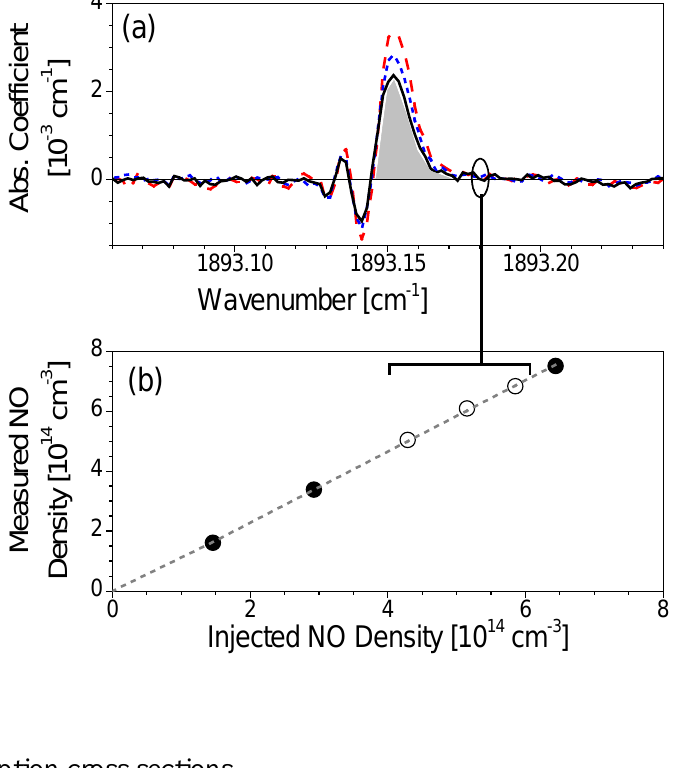
Figure 4. Sample spectrum and calibration curve of a stable molecular species, NO, obtained with a pulsed QCL under low pressure conditions. (a) Perturbed absorption coefficients of NO measured at 2.66 mbar (50 cm absorption length) for different mixing ratios (dashed—1.00%, dotted —0.80%, solid—0.67%. The patterned area was used to calculate number densities (at 296 K) which are plotted in (b) as open symbols (full symbols represent values at different pressures). The resulting correlation was then used to correct for non-linear absorption phenomena (adapted from